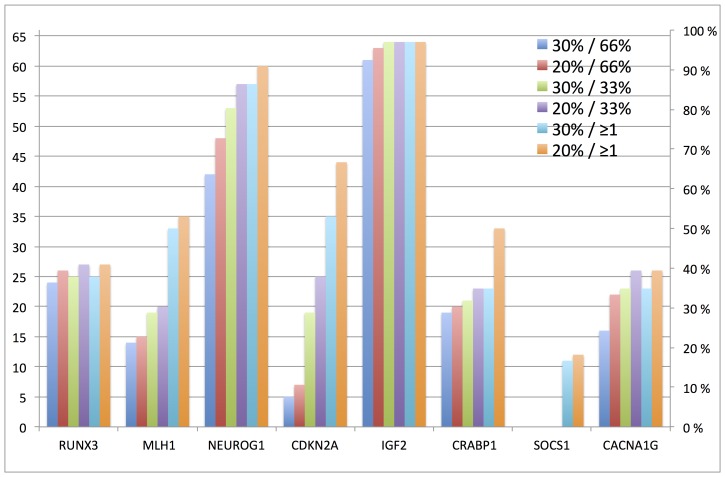
The number (left vertical axis) and percentage (right vertical axis) of samples scored as positive for each gene using all combinations of probe- and gene-wise cut-offs.